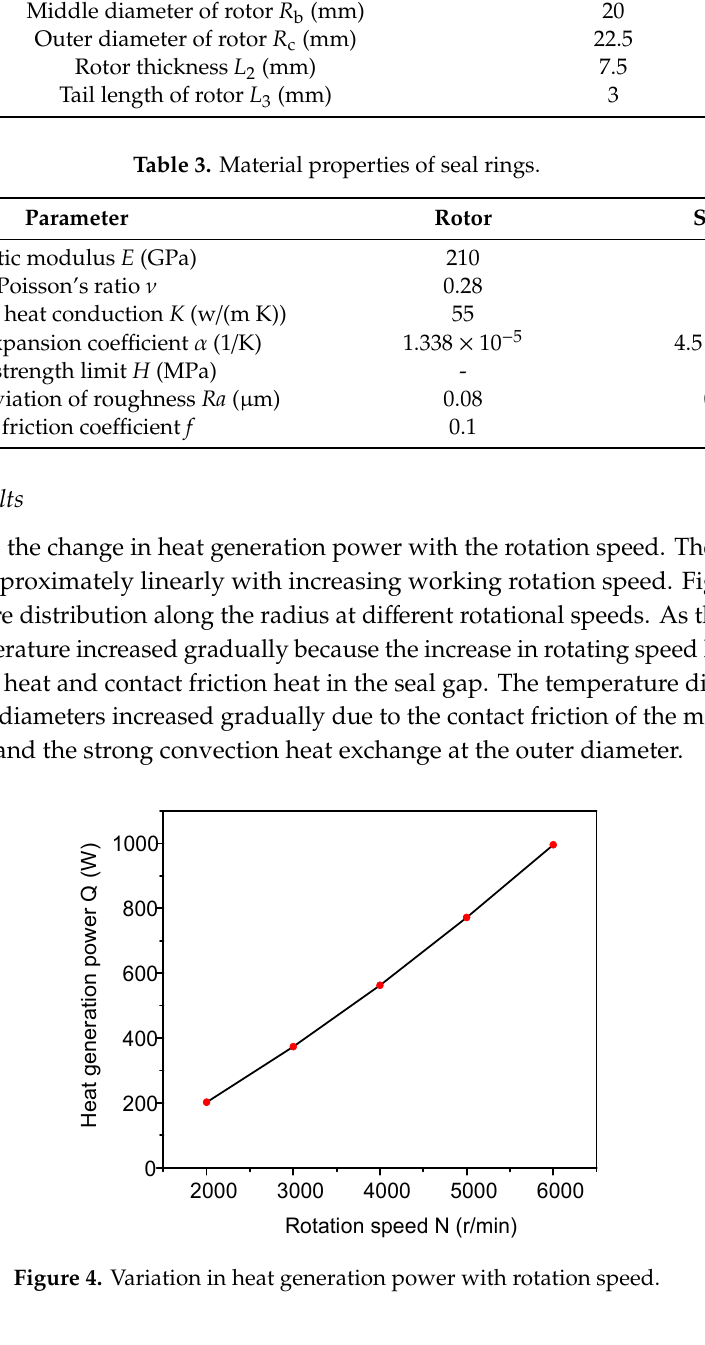
Figure 5. End face temperature distribution over the end face radius at different rotation speeds.